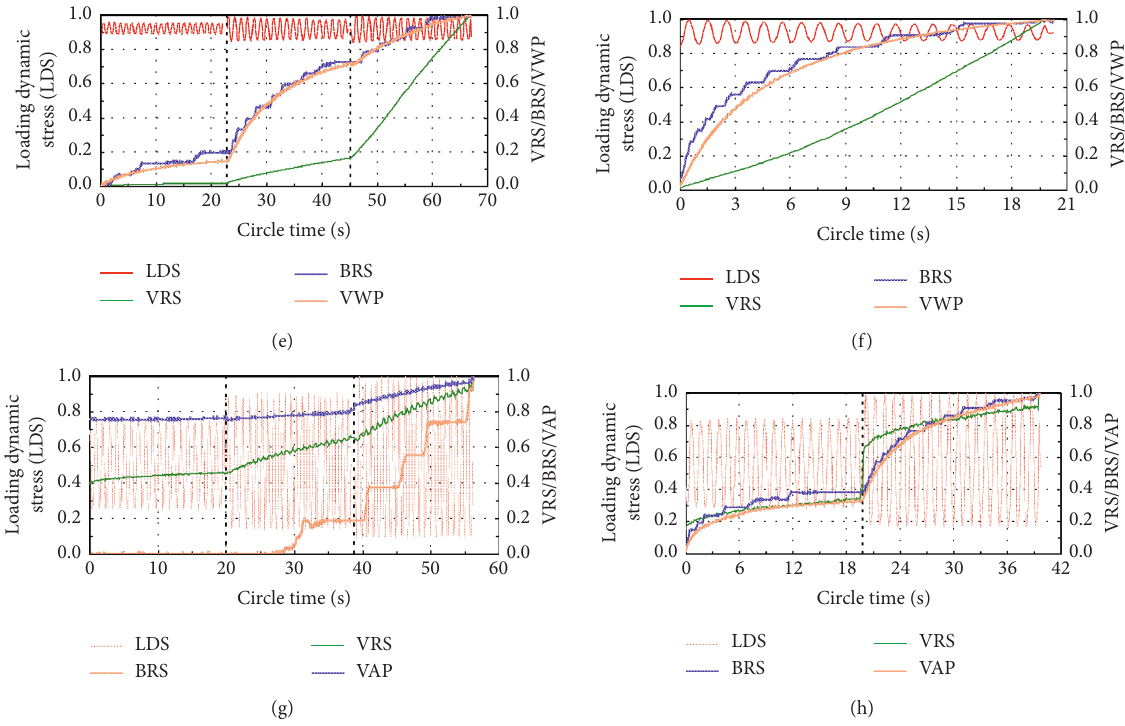
Figure 4: Response process of natural loess under static/dynamic loadings (normalized by the maximum value of testing data). (a) Samples 1–3 (US). (b) Samples 1–3 (US). (c) Samples 4–6 (SS). (d) Samples 4–6 (SS). (e) Sample 7 (SD). (f) Sample 8 (SD). (g) Sample 9 (UD). (h) Sample 10 (UD).